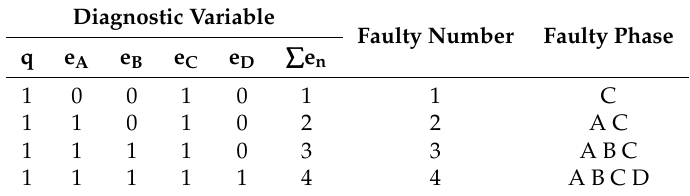
Table 2. Diagnostic variable for the phase winding